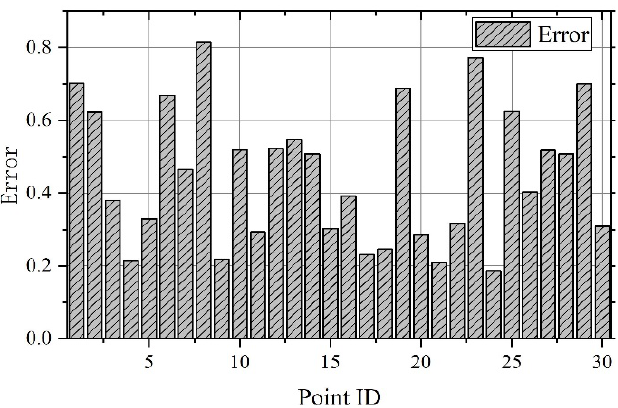
Figure 9 Point clouds accuracy evaluated by terrestrial laser